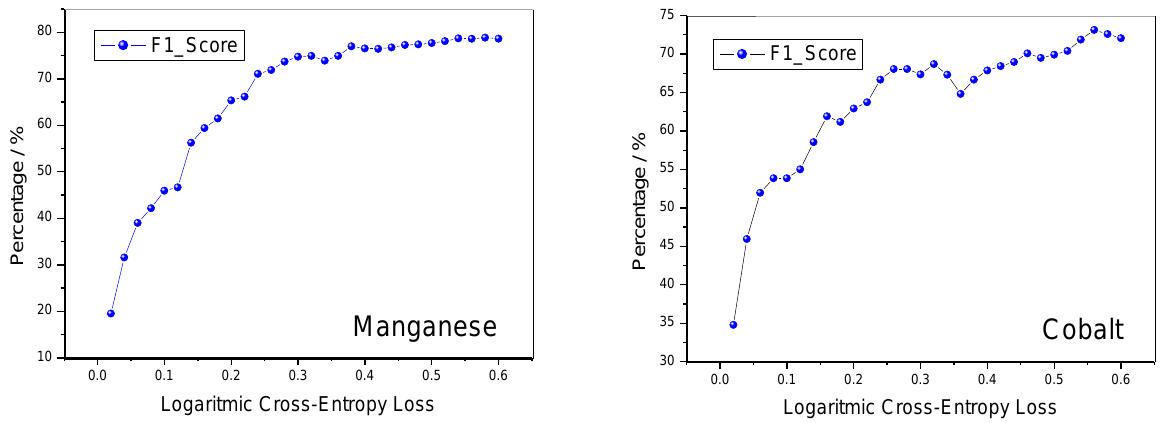
Figure 5. F1_Score value as a function of LCEL value for lithiated manganese ( left ) and cobalt ( right ) oxides.